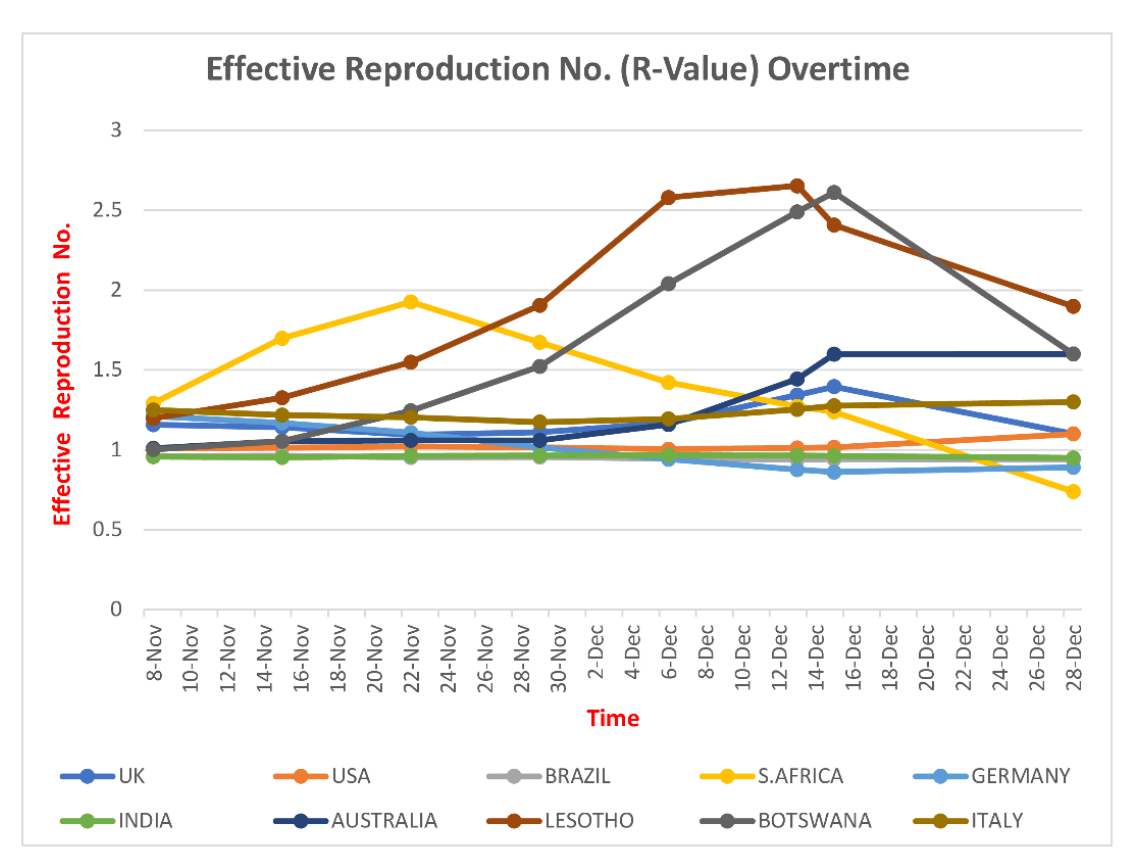
Figure 8. Effective reproduction number of SARS-CoV-2 of ten selected countries from 8 November 2021 to 28 December 2021 (data source: CMMID).